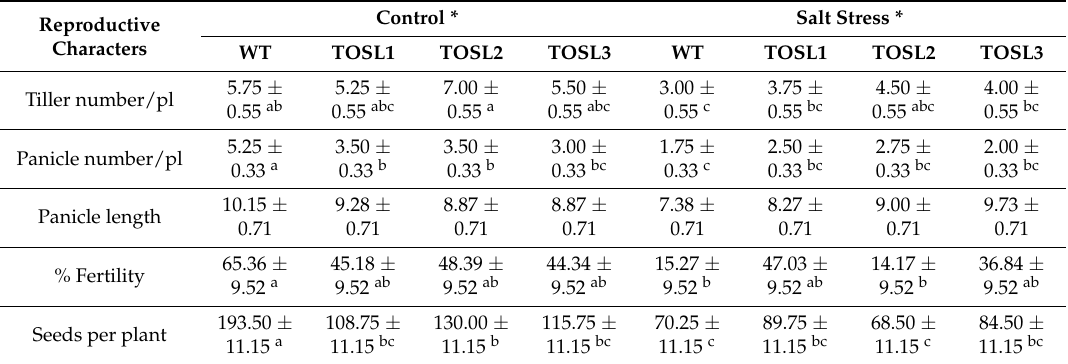
Figure 1. OsNUC1 gene expression in wild type (WT) and OsNUC1-S over-expression lines, TOSL1, TOSL2, and TOSL3, in the control and salt stress condition. Analysis of variance was performed and means were compared with Tukey’s range test analysis. The data were presented as the mean ± SE and a different letter above the bar showed the significant difference in means ( p < 0.05). ns represents no statistically difference among means. Table 1. Effects of salt stress at reproductive stage on tiller number per plant, panicle number per plant, panicle length, % fertility, and seed number per